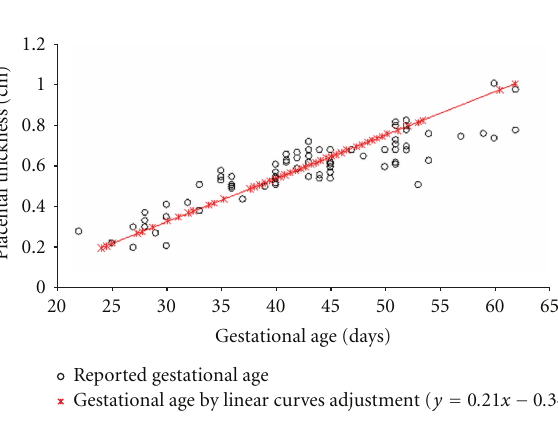
Table 1: Comparison between gestational age and reported age averages for the three evaluated breeds and statistical analysis. Average Standard deviation Average standard error P Breed n RGA GA RGA GA RGA GA Small size 138 Medium size